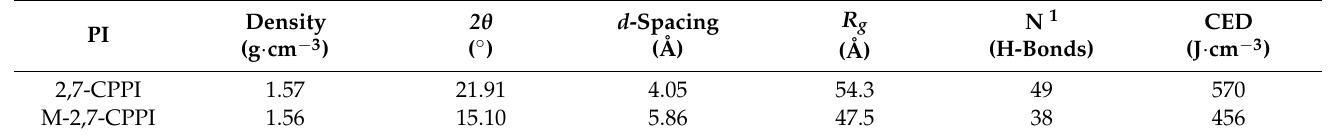
Figure 3. WAXD curve of M-2,7-CPPI and 2,7-CPPI films. Table 3. Physical properties of the M-2,7-CPPI and 2,7-CPPI.